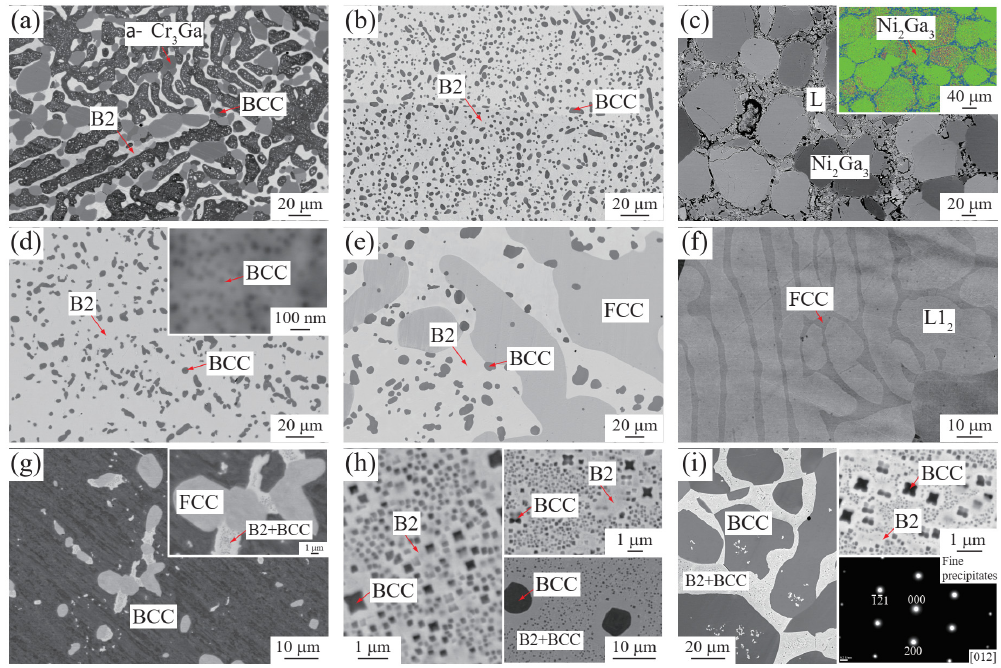
Figure 2. Microstructures of: ( a ) Ni9.24-Ga20.81-Cr69.95 (at. %, 60 days), ( b ) Ni46.31-Ga25.36-28.33Cr (60 days) and ( c ) Ni33.23-Ga62.74-Cr4.03 (2 h, the inset is the EBSD result) annealed at 850 °C, ( d ) Ni44.19-Ga26.80-Cr29.01 (the inset is a high magnification image), ( e ) Ni50.20-Ga21.02-Cr28.78 and ( f ) cold-rolled Ni77.85-Ga18.47-Cr3.68 annealed at 1000 °C for 35 days, ( g ) Ni7.40-Ga2.68-Cr89.92 (the inset is high magnification image), ( h ) Ni45.98-Ga25.50-Cr28.52 (the insets are the microstructures formed when annealed at 1150 °C for 24 h (upper) and 1135 °C for 10 days (lower)) and ( i ) Ni16.54-Ga13.63-Cr69.83 annealed at 1150 °C for 10 days (the insets are the NiGa + BCC region (upper) and the SAD pattern of fine precipitates (lower)).